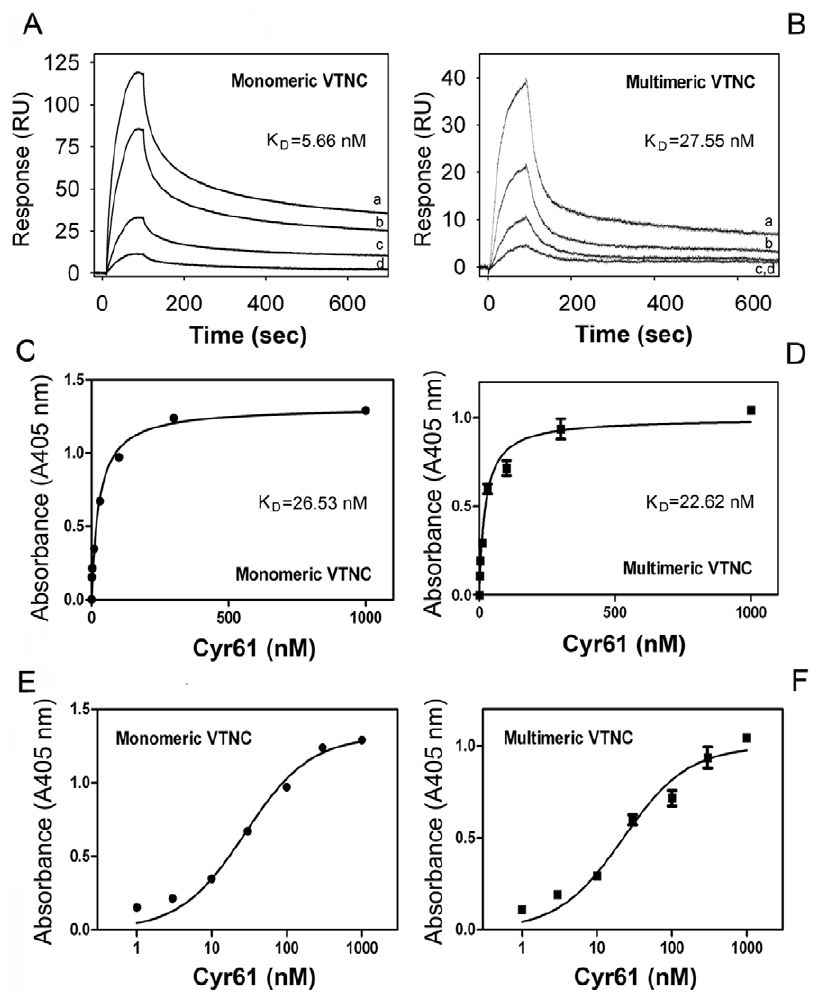
Figure 2. Cyr61 displays high-affinity binding to immobilized VTNC. ( A ) Sensorgrams for Cyr61 (in nM: a , 40; b , 20; c , 5; d , 2.5) binding to immobilized monomeric VTNC. ( B ) Sensorgrams show Cyr61 (in nM: a , 50; b , 25, c , 12.5; d , 6.25) binding to multimeric VTNC. Data were fitted using global two-state binding model. RU, resonance units. ( C ) and ( D ) solid-phase-binding assay for Cyr61 (0–1 m M) interaction with immobilized monomeric or multimeric VTNC, respectively. Binding was estimated with anti-Cyr61 monoclonal antibody followed by alkaline-phosphatase labeled anti-mouse secondary antibody and appropriate substrate as described in Materials and Methods. ( E ) and ( F ) Semi log-transformation of the data depicted in ( C ) and ( D ), respectively. The (apparent) K D values for Cyr61/VTNC interactions were calculated by nonlinear regression analysis of the binding data according to the Langmuir isotherm equation. All treatments were performed in quadruplicate or quintuplicate (n=3).